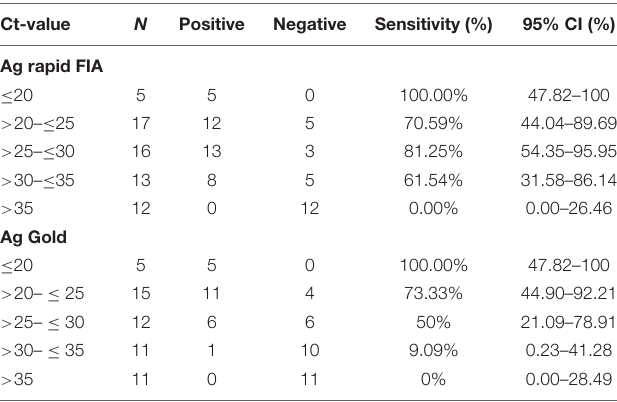
TABLE 3 | Sensitivity of Ag rapid FIA and Ag Gold assays determined by SARS-CoV-2 N gene rRT-PCR cycle threshold (Ct) value. Ct-value